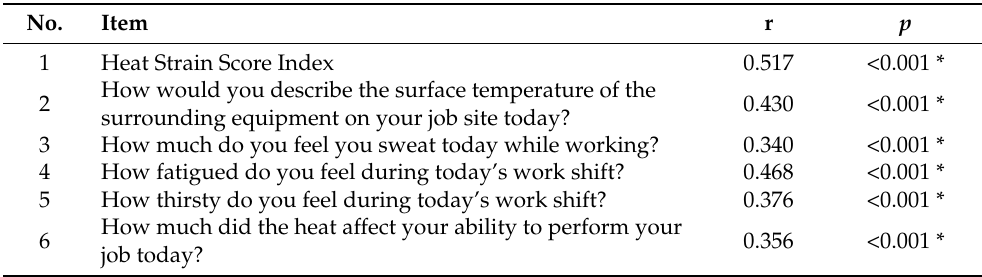
Table A2. Association between “the perceived thermal radiation” and subjective psychophysical parameters derived from the Heat Strain Score Index. * indicates statistically significant association at a Bonferroni adjusted alpha of 0.003.